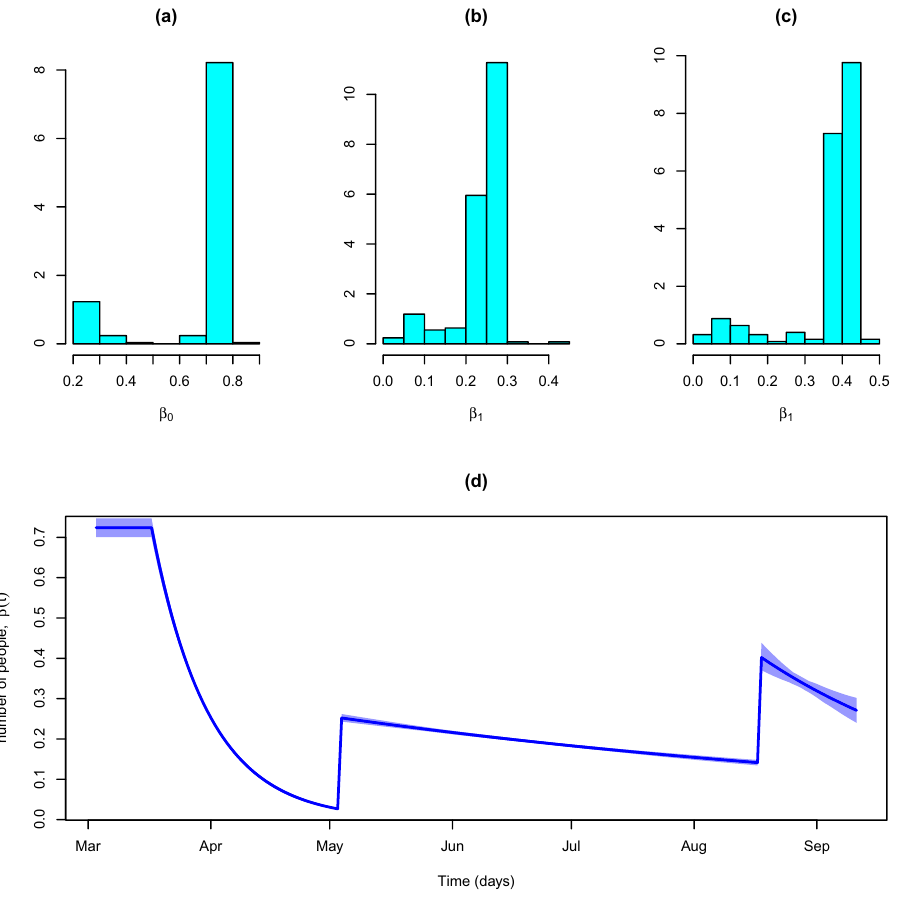
Figure 10. Transmission rate, β t . ( a ) Initial transmission rate distribution, β 0 . ( b ) Transmission rate distribution after the second intervention, β 1 . ( c ) Transmission rate distribution after the third intervention, β 2 . ( d ) Course of the transmission rate, β( t )